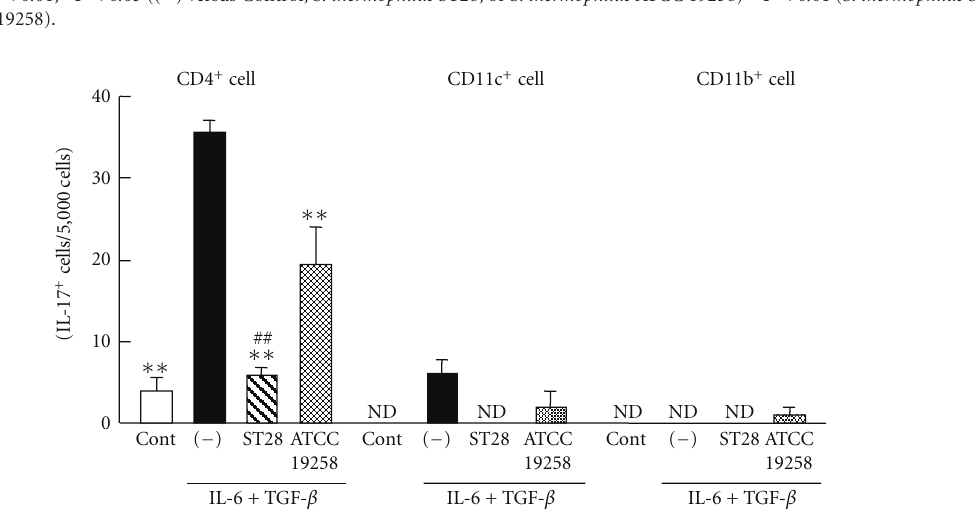
n.d., not detected. ∗∗ P < 0 . 01, ∗ P < 0 . 05 (( − ) versus Control, S. thermophilus ST28, or S. thermophilus ATCC 19258) ## P < 0 . 01 ( S. thermophilus ST28 versus S. thermophilus ATCC 19258).